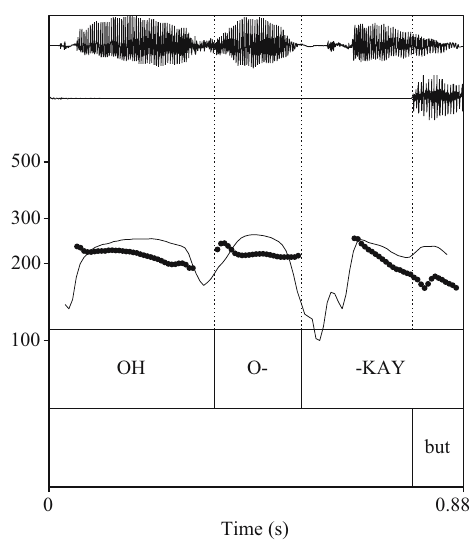
Figure 5: Pitch trace and intensity curve for lines 17 – 18 of Ex. ( 9 ) “ Faculty meeting ”